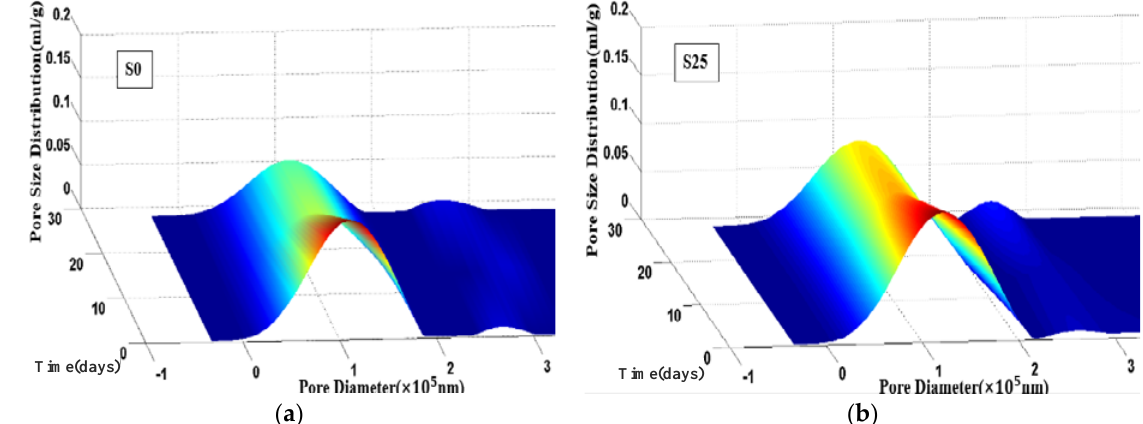
Figure 12. Development of pore size distribution of of S0 and S25 with age.